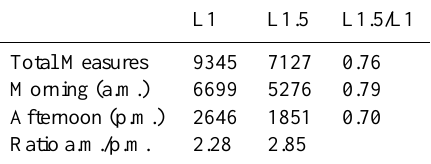
Table 1. Number of direct-sun measurements performed at Ev-K2- CNR in the period April 2006–March 2007. L1 and L1.5 indicate unscreened and cloud-screened observations,